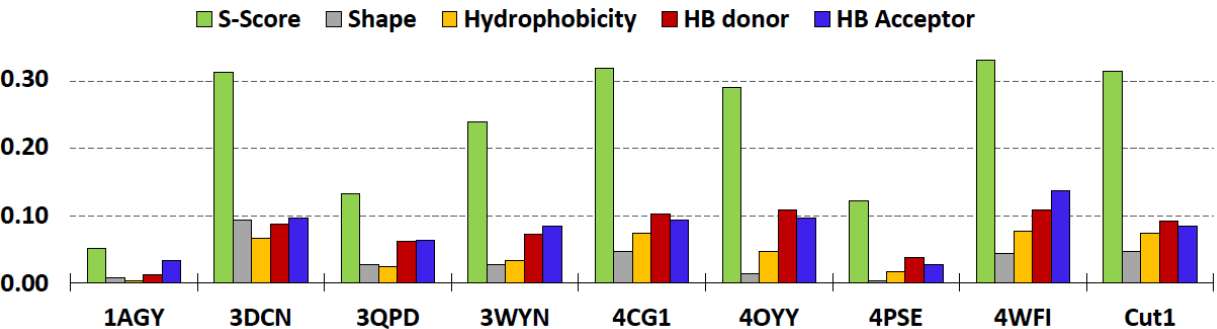
Figure 4. Score deviation from the average values calculated for each cutinase of the data set. Color code: shape (gray), DRY probe (hydrophobicity, yellow), O probe (H–Bond donors, red) and N1 probe (H-Bond acceptors, blue).